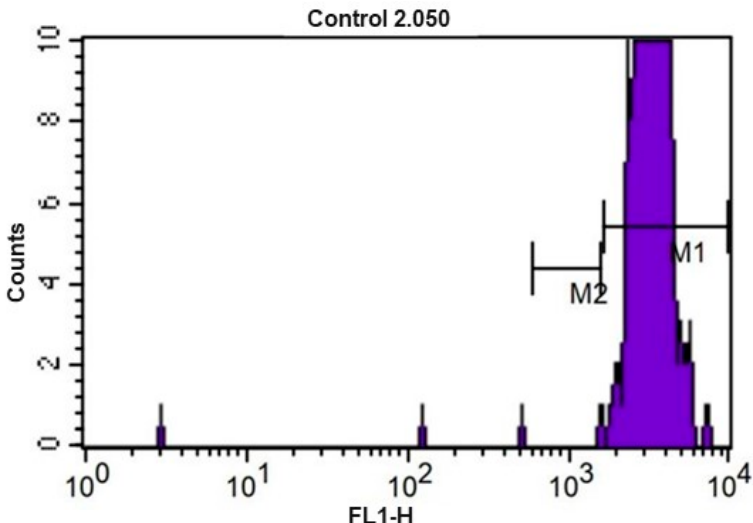
Figure 5. CFSE fluorescence histogram (carboxyfluorescein diacetate) of equine peripheral blood lymphocytes after culture for 72 h at 5% CO 2 and 37 °C without use of mitogens (control). M1 and M2 represent the markers used to enumerate the events of each division cycle that the software used for calculating the proliferation index.